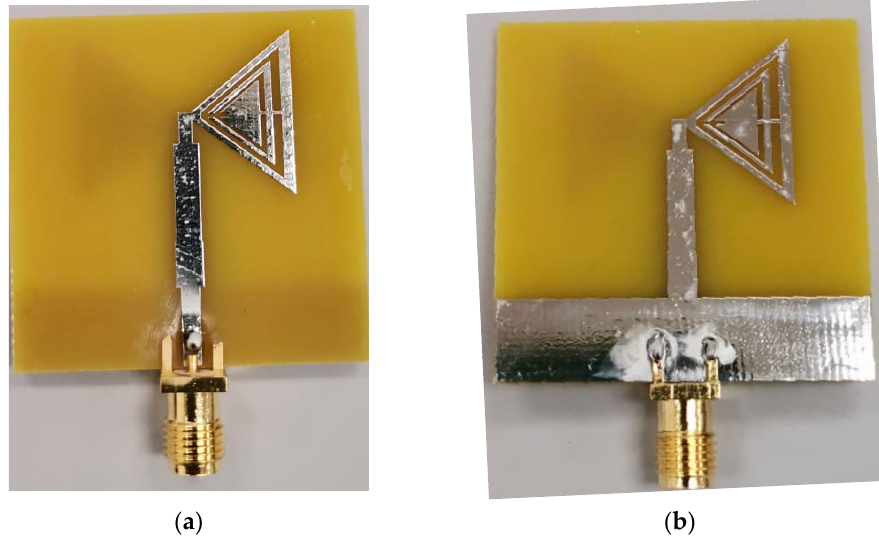
Figure 6. Fabricated antenna prototype: ( a ) top view, and ( b ) bottom view.